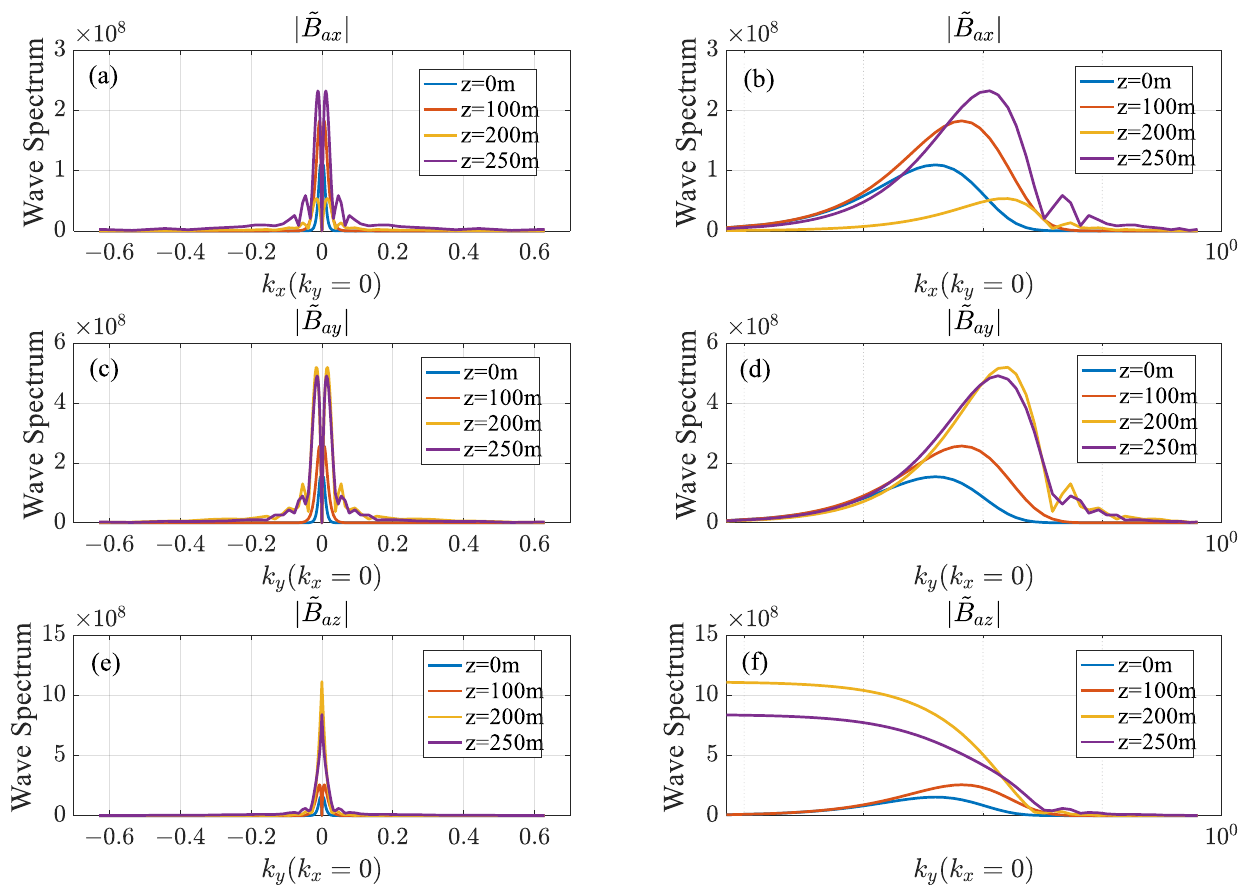
Figure 14. Spectrum distribution of strong magnetic field at different depths. The horizontal ordinate of figures ( a , c , e ) is non-logarithmic, and the horizontal ordinate of figures ( b , d , f ) is logarithmic.